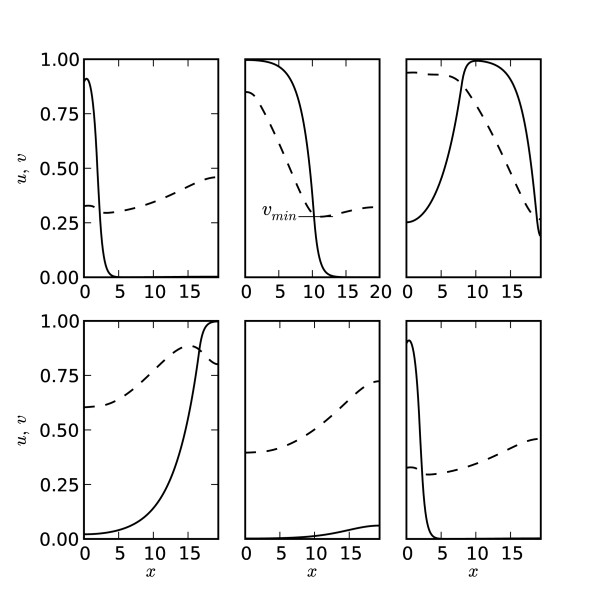
Formation and propagation of a pulse. Formation and propagation of a pulse between successive pacing stimuli applied at the left end of the cable (vr = 0.19, vmin = 0.29, and Th = 9.0 measured at x0 = 10). Solid and dashed lines show spatio-temporal dynamics of u and v, respectively. The first and last snapshots correspond to the moments when two successive pacing stimuli are applied. Time intervals between the snapshots are equal to 7.2 (20% of the pacing period).